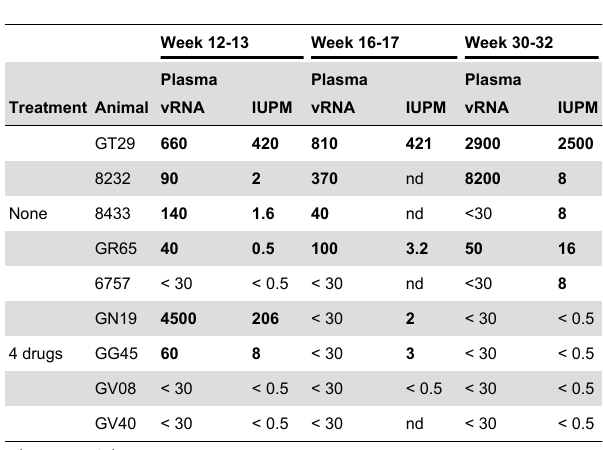
Table 3. Detection of replication-competent RT-SHIV from resting CD4+ T cells from lymph node